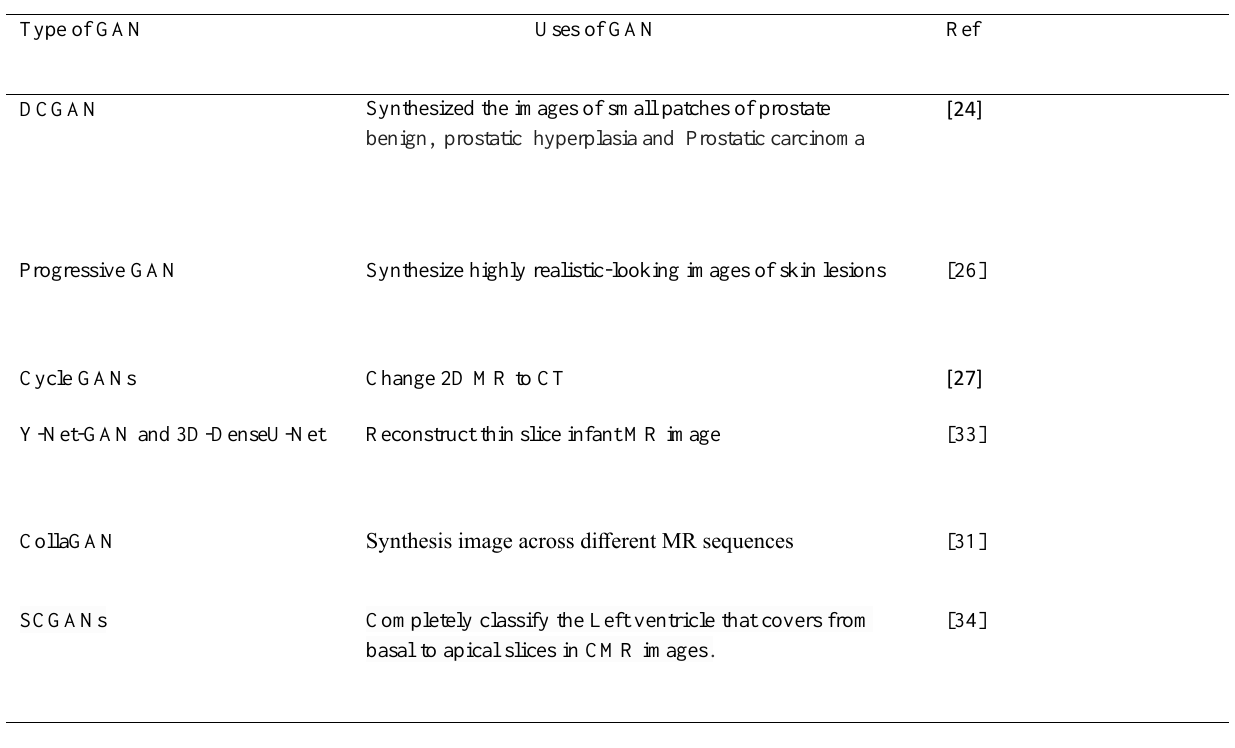
Table1 .Summary of GAN in Medical Image